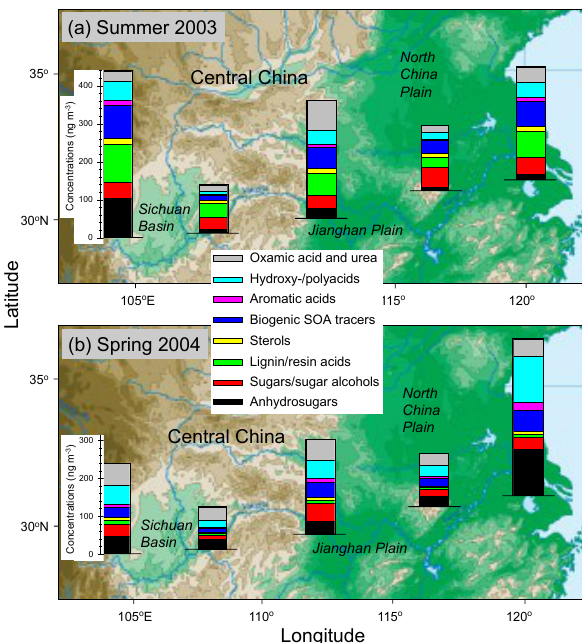
Fig. 2. Spatial distributions of organic compound classes measured in the aerosol samples (PM 10 ) collected over central China. Con- centrations of organic species from flights over local cities are av- eraged for their local abundances, while concentrations of organic compounds in the samples collected during the round flights be- tween two cities are averaged and shown as a column in the middle of the cities.